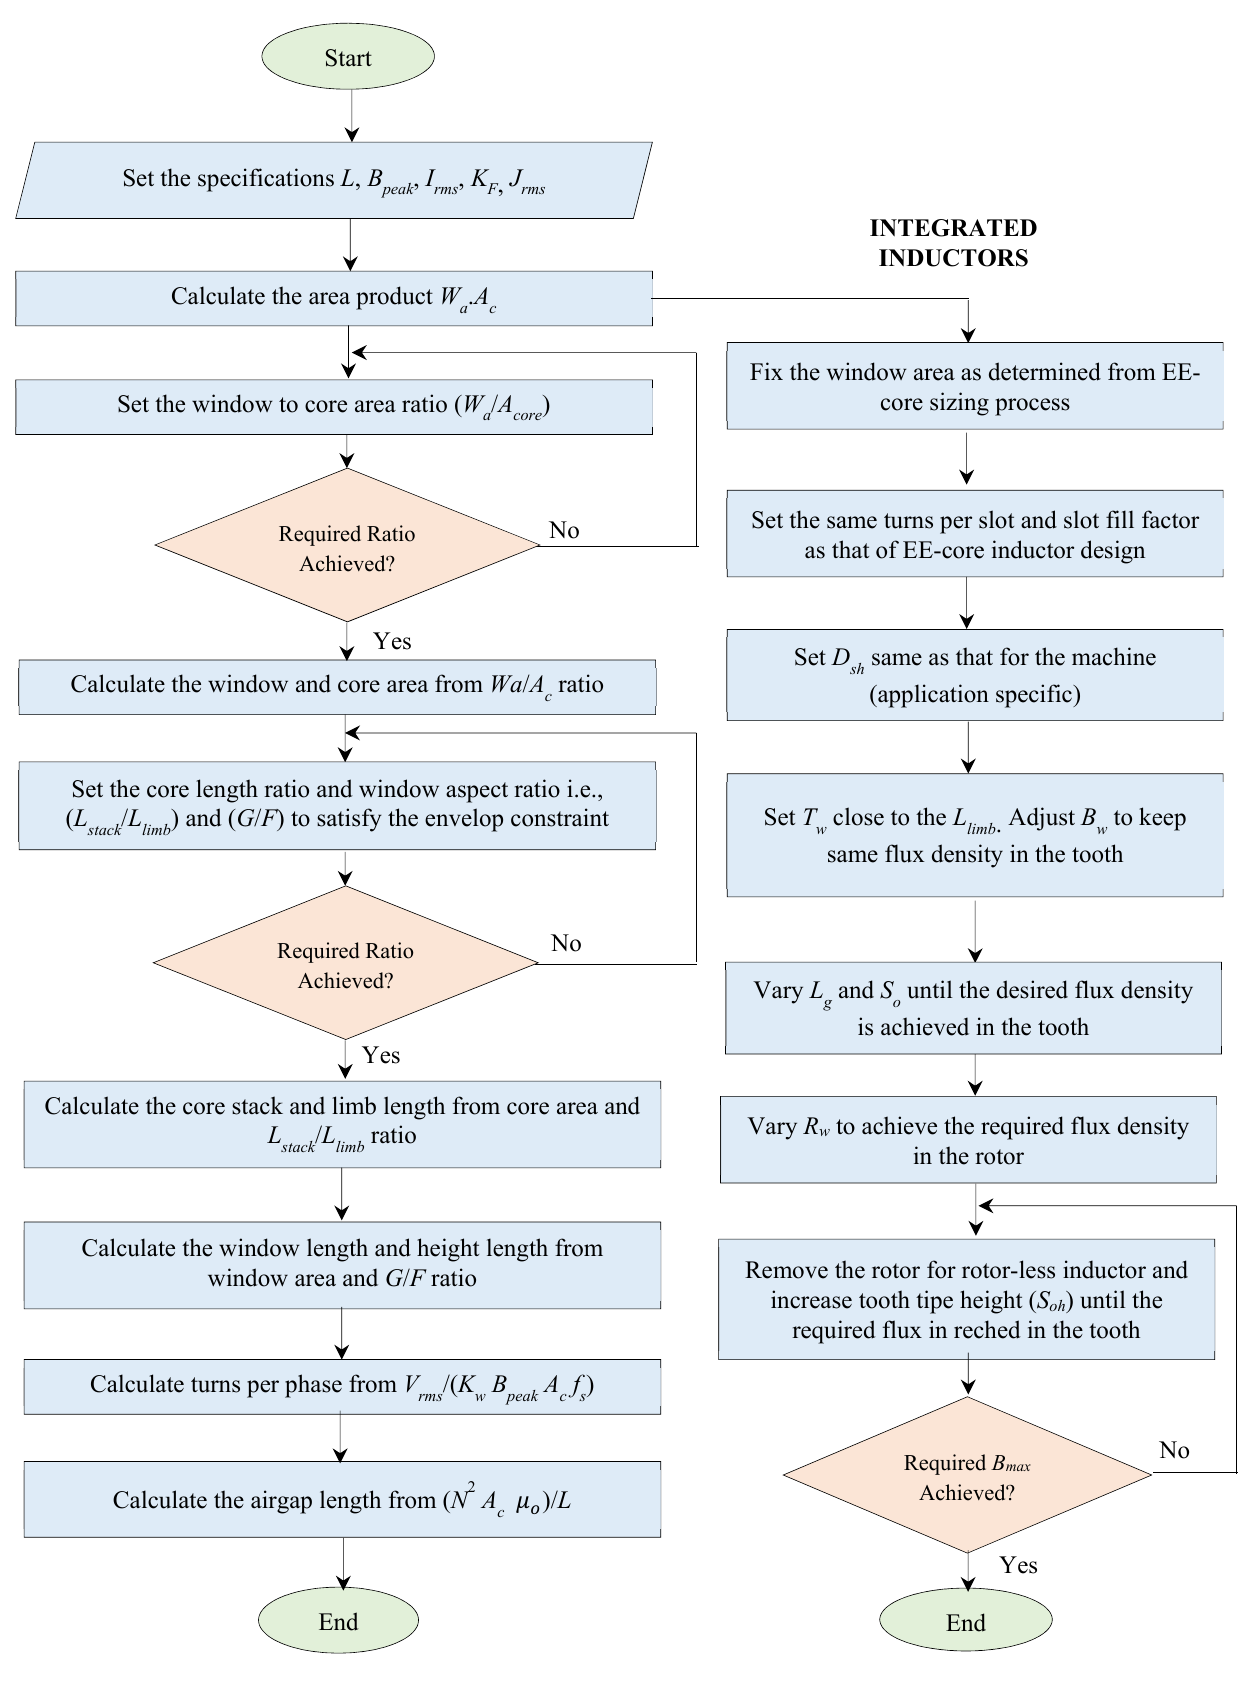
Figure 2. Sizing Algorithm of EE-Core and Integrated Inductor.